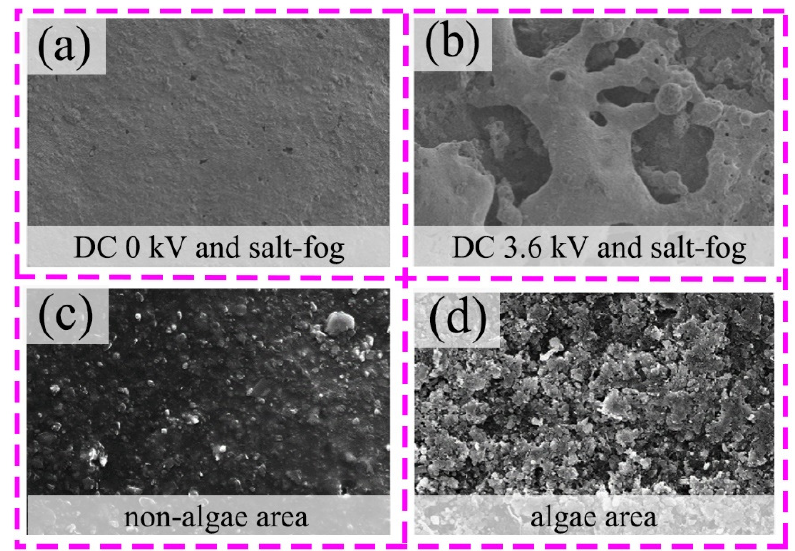
Figure 2. Electron microscope image of an insulator after environmental pollution. ( a , b ) Electron microscope diagrams of 0 KV, 3.6 KV insulator in a salt fog environment. ( c , d ) Electron microscopic comparison of insulators before ( c ) and after ( d ) algae pollution.